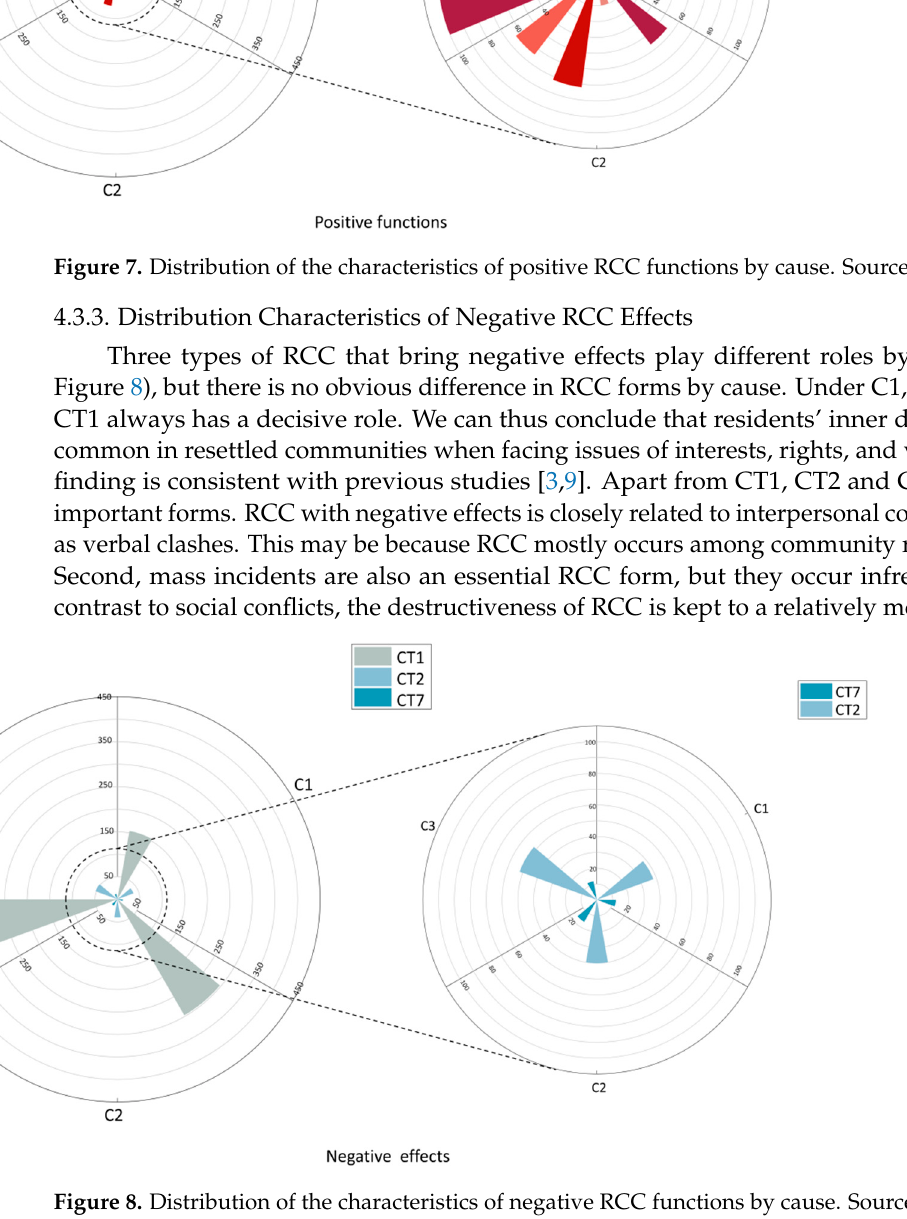
Figure 8. Distribution of the characteristics of negative RCC functions by cause. Source: Authors.